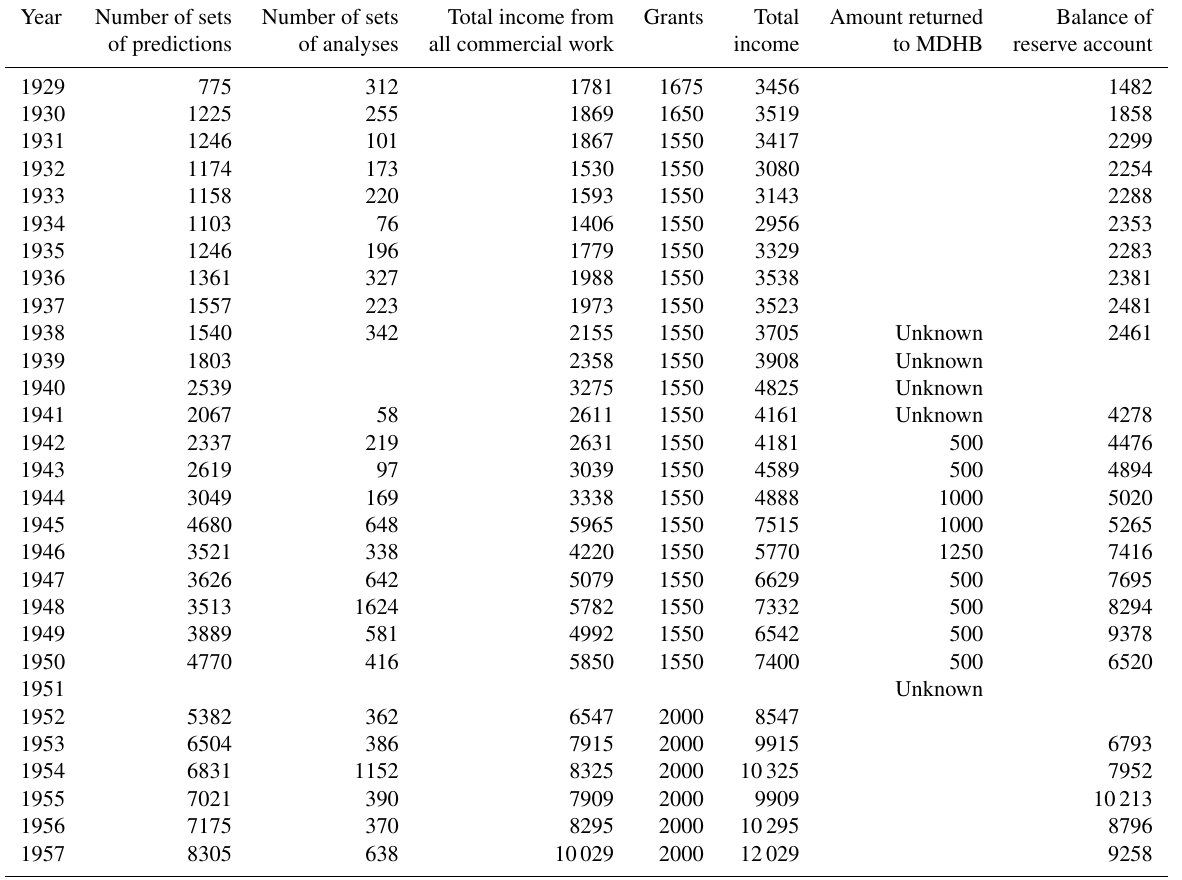
Table 2. Some of TI’s income streams, the sum they returned to MDHB between 1938 and 1951, and the balance of TI’s reserve account, all in pounds by year.